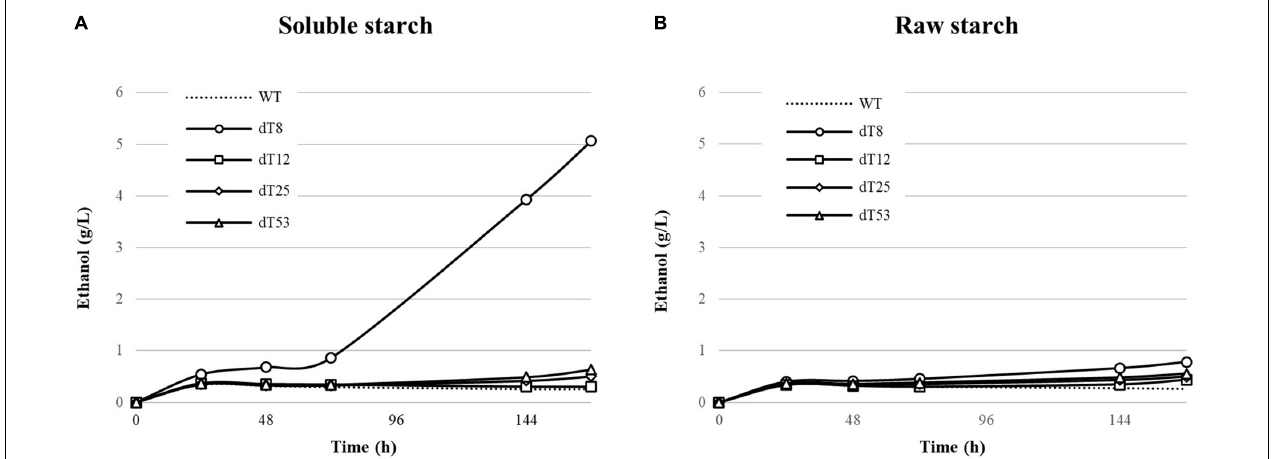
FIGURE 6 | Ethanol production from 2% (w/v) soluble (A) and raw starch (B) by delta integrated S. cerevisiae L20 recombinants. WT indicates the parental strain. Strains were cultivated in YP medium with 0.05% glucose supplementation in oxygen-limited conditions. Values represent the mean of three replicates. The parental strain was used as